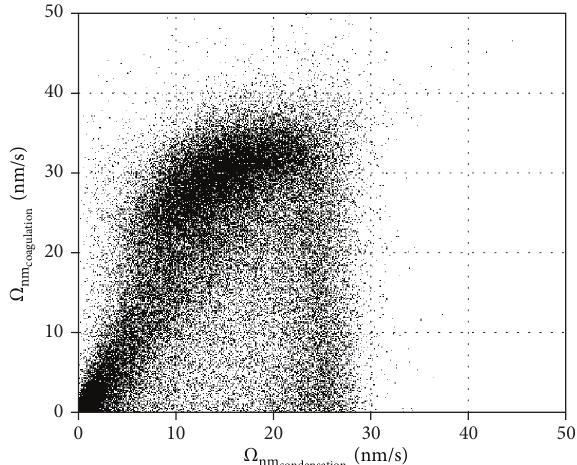
Figure 9: Scatter plot of the particle growth-rate by condensation versus the particle growth-rate by